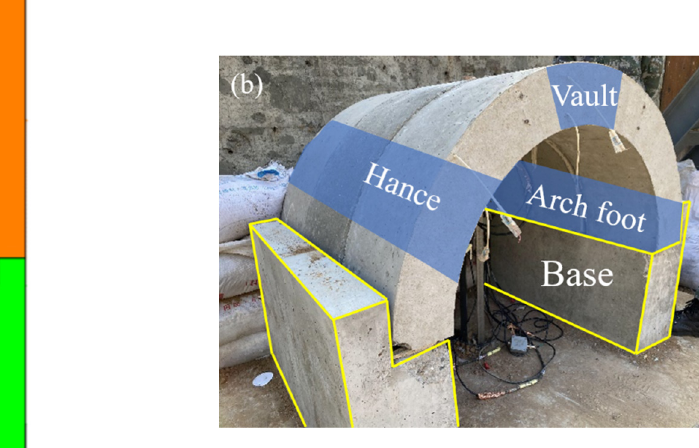
Figure 4. ( a ) Schematic diagram of the shallow buried BBCA (mm), and ( b ) Assembling of the ex- perimental arches and the base [25].